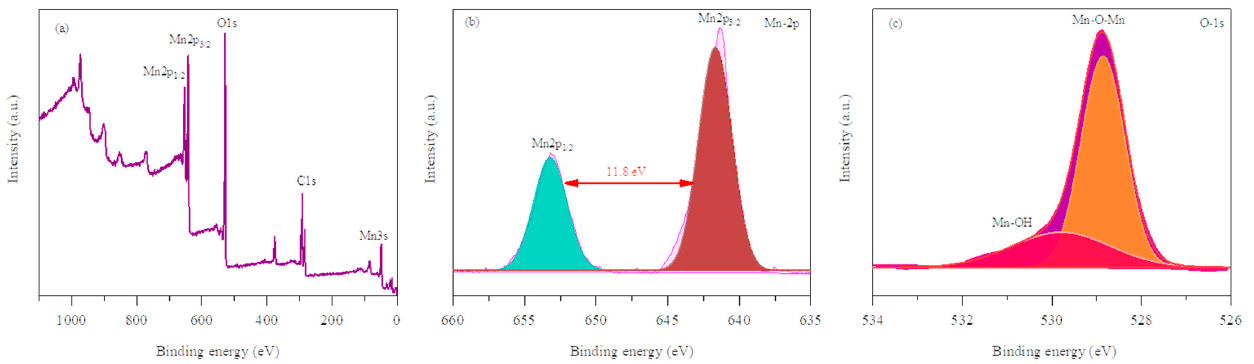
Figure 2. ( a ) Infra-red (IR) spectra; ( b ) Raman spectra of the calcined δ− MnO 2 sample.